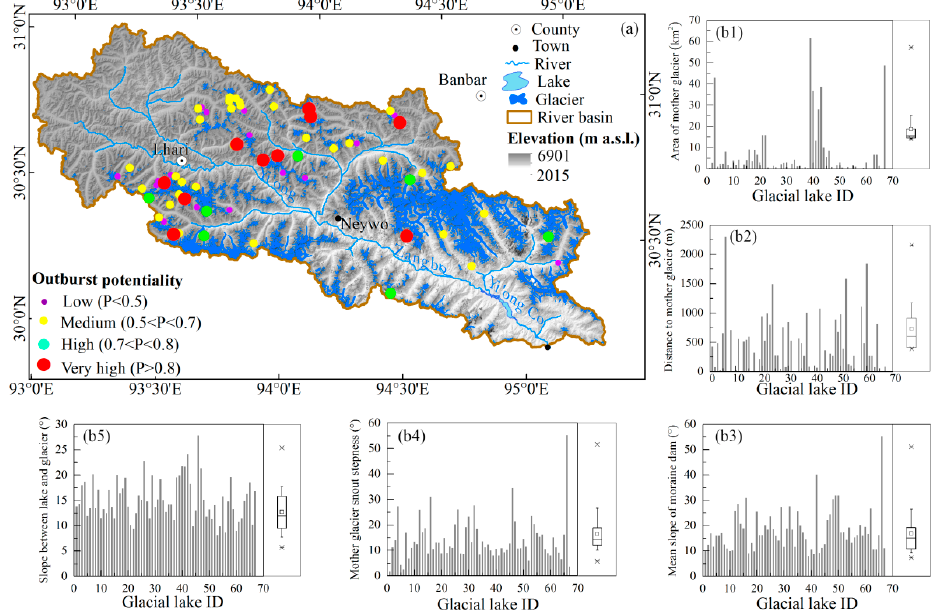
Figure 7. Distribution of glacial lakes with different outburst potentials in the Yi’ong Zangbo River Basin and the calculated danger values of five indicators for the 67 target glacial lakes.